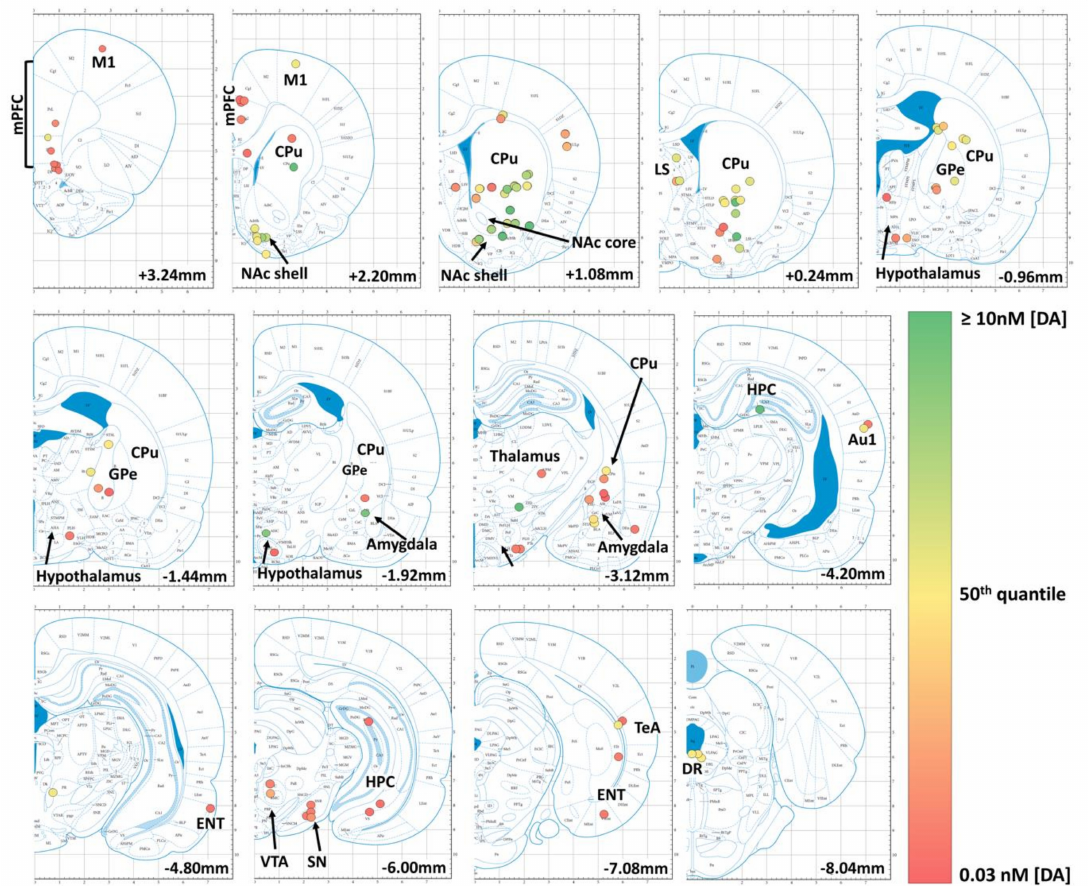
Figure 3. Graphical representation of previously reported basal dopamine concentrations measured via intracerebral microdialysis experiments performed in rats. Coronal brain sections from AP + 3.24 mm to AP -8.04 mm (relative to bregma) are depicted. The colored circles indicate the reported positions of the microdialysis probes and the fill color of the circles is color-coded to represent the values of the reported basal dopamine concentrations. Of note, the striatal basal dopamine concentrations are amongst the largest in rat brain (brain sections AP + 1.08 mm and AP + 0.24 mm). Importantly, the basal dopamine levels do not represent phasic dopamine release since they are predominantly measured during baseline at rest and are a result of dialysate collection times in the range of several minutes.